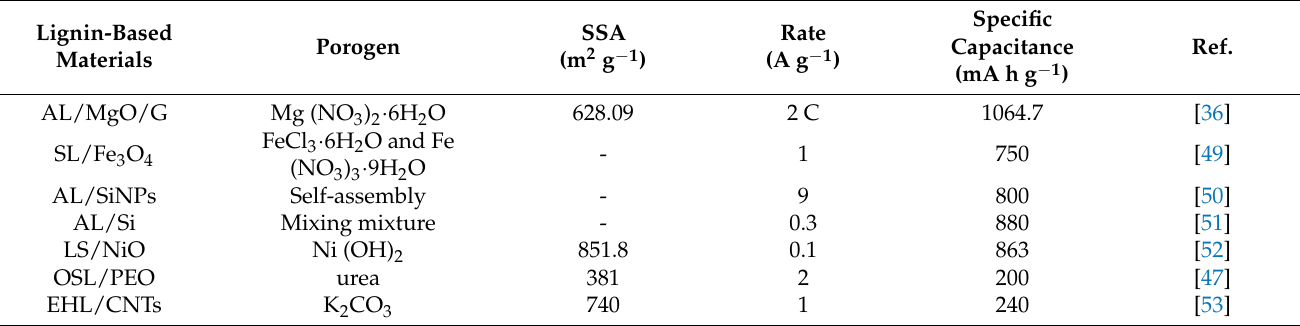
Table 3. Specific capacity of composite lignin-based electrodes for